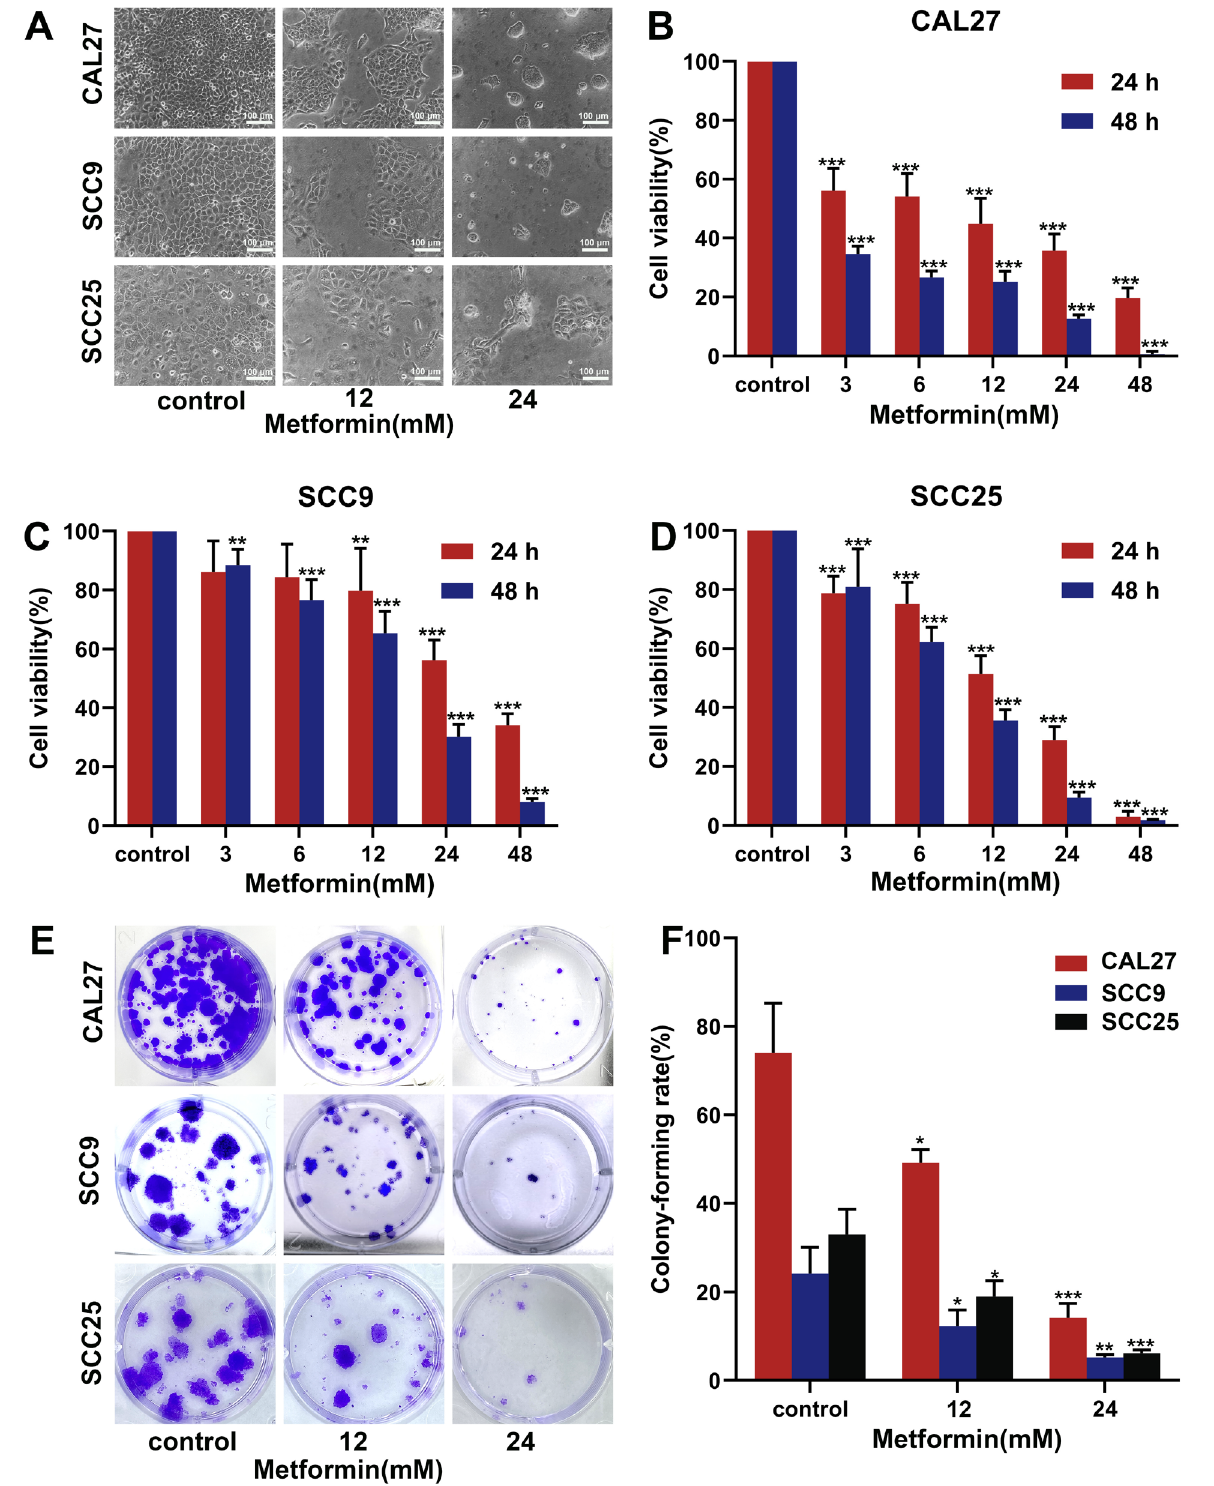
Figure 1. Metformin inhibited the ability of proliferation and colony-forming in OSCC cells. ( A ). The OSCC cell lines (CAL27, SCC9, SCC25) were incubated with different concentrations of metformin for 24 h, and then the cell morphology was observed by the inverted microscopy. The magnification = 100 × , scale bars = 100 µ m. ( B – D ) The OSCC cell lines were treated with the gradient concentrations of metformin for 24 h and 48 h, and then the CCK-8 assay was used to detect the cell viability. ( E , F ) The OSCC cell lines were treated with different concentrations of metformin for 48 h and incubated with fresh culture medium for 12 days. The cells were